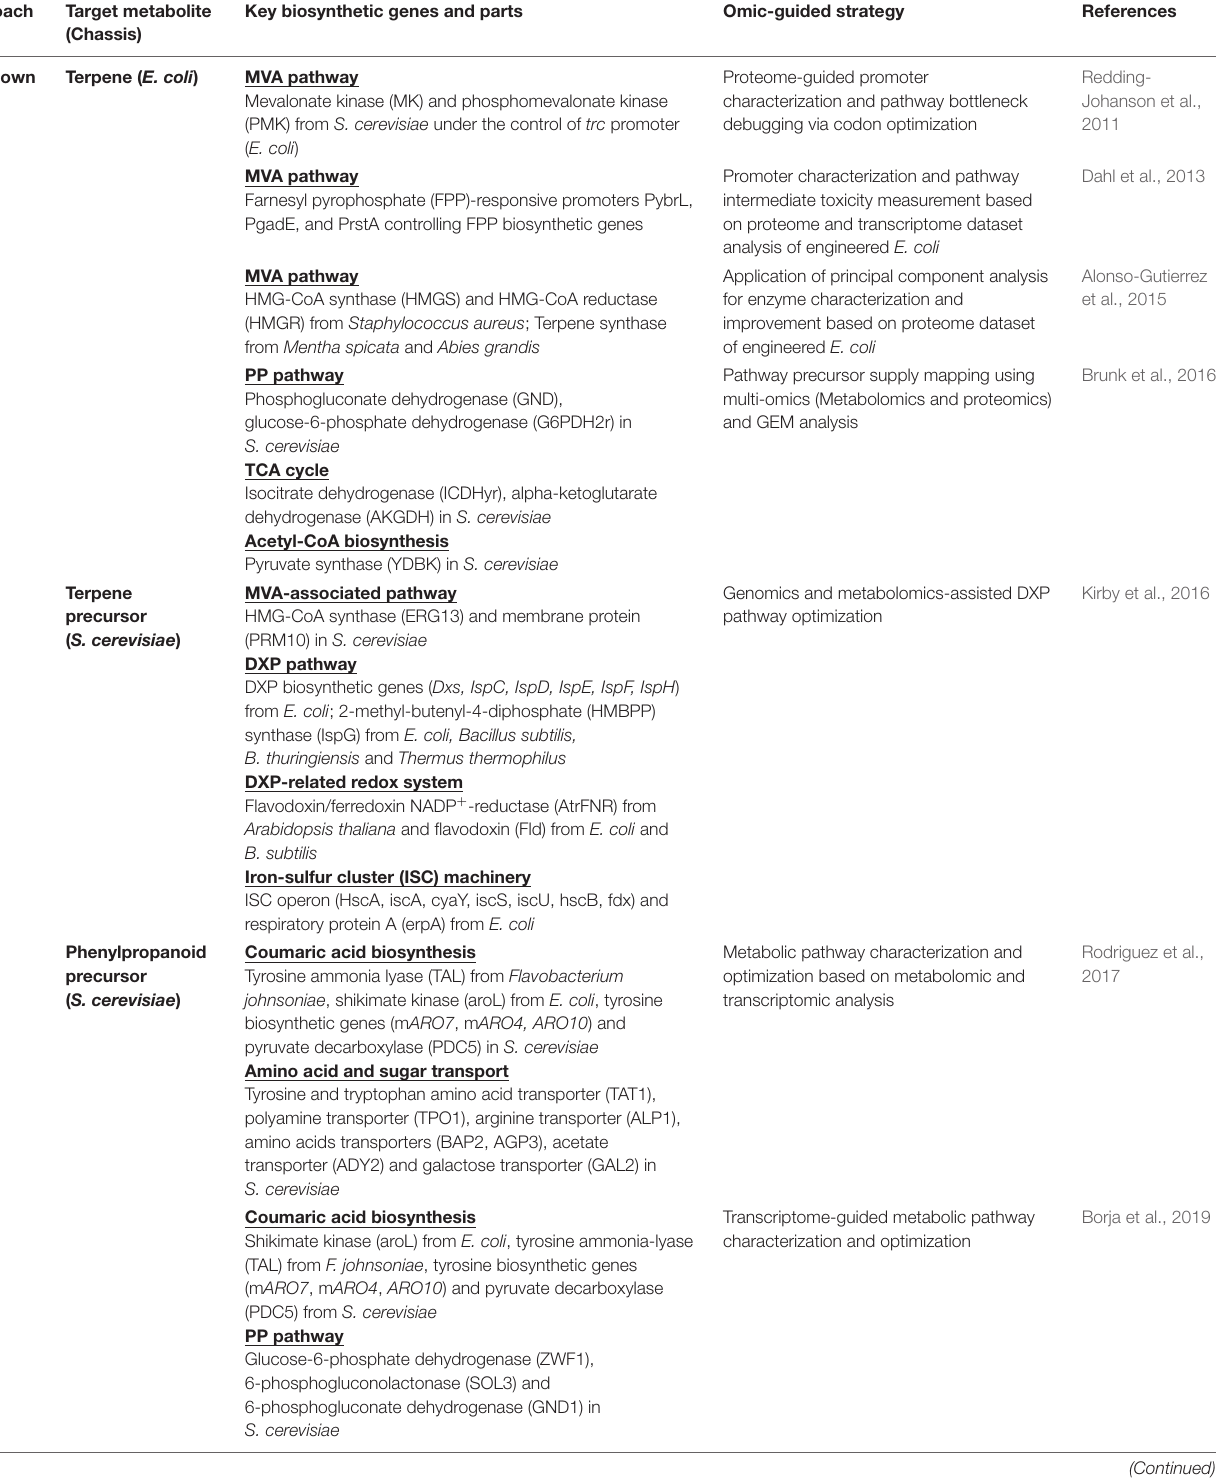
TABLE 1 | Omics-guided microbial engineering approaches for natural product and precursor biomanufacturing. Top-down approach mainly represented pathway debottlenecking and strain optimization for increasing bioproduction capacity. Bottom-up approach utilized transcriptome-enabled gene discovery for pathway engineering, refactoring, and bioproduction of industrially important natural products. MVA, mevalonate; PP, pentose-phosphate; TCA, tricarboxylic acid; DXP, 1-deoxy- D -xylulose 5-phosphate; BIA, benzylisoquinoline alkaloid.